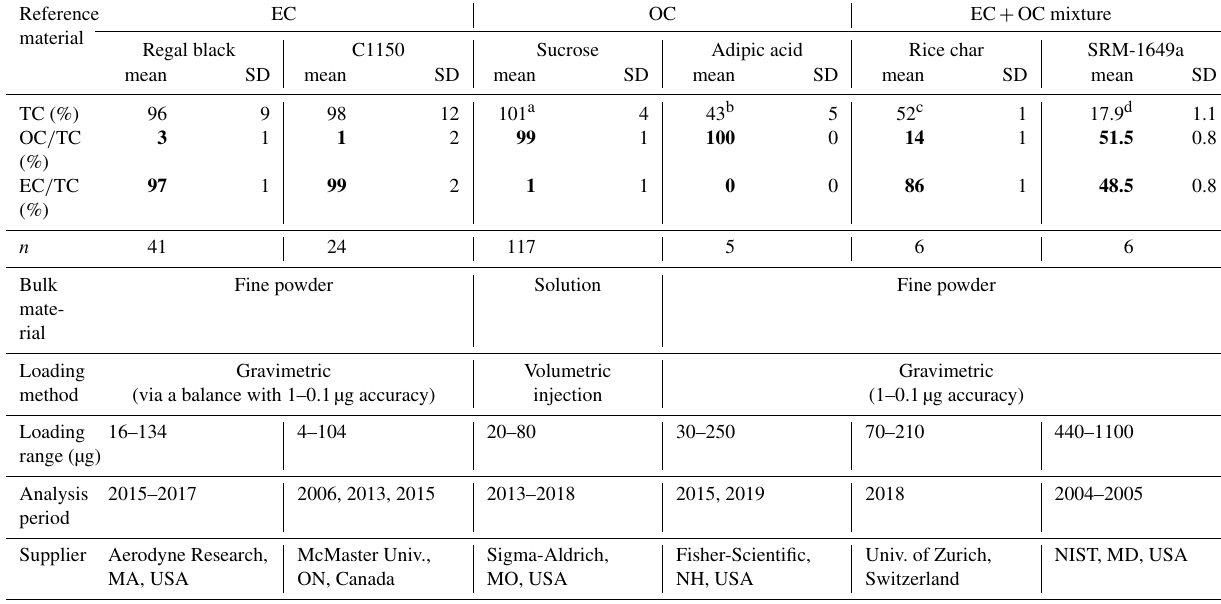
Table 1. Overview of the bulk reference materials analyzed with the ETC9 method for their total carbon (TC), organic carbon (OC), and elemental carbon (EC)